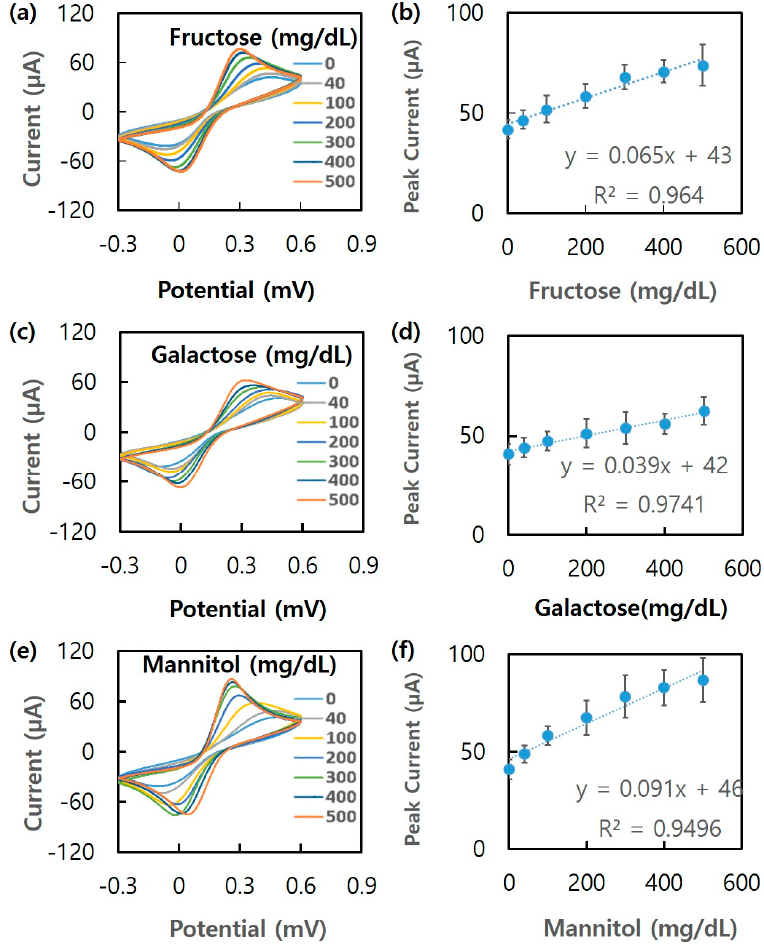
Figure 8. Electrochemical selectivity of DA-immobilized electrode for detecting saccharides. in the range of 0–500 mg/dL. 50 µL of 0.1 × PBS (pH 7.4) congaing 10 mM Fe(CN) 63 − /4 − , 0.1 M KCl, was applied to the electrodes and CV measurements were carried out ( a , c , e ) Cyclic voltammograms and ( b , d , f ) corresponding peak currents obtained using fructose, mannitol, and galactose,